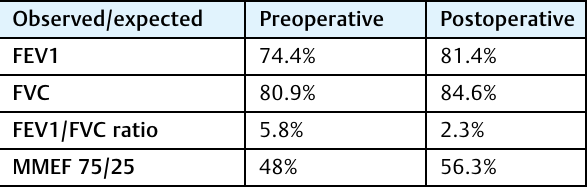
Table 1 Spirometryparameters:preoperativeversuspostoperative Observed/expected